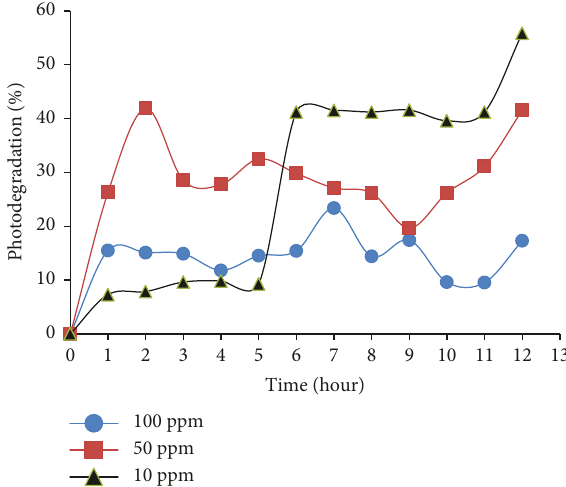
Figure 7: Variation of % of photodegradation versus for time of sample SA1 (0.3g) under sunlight.